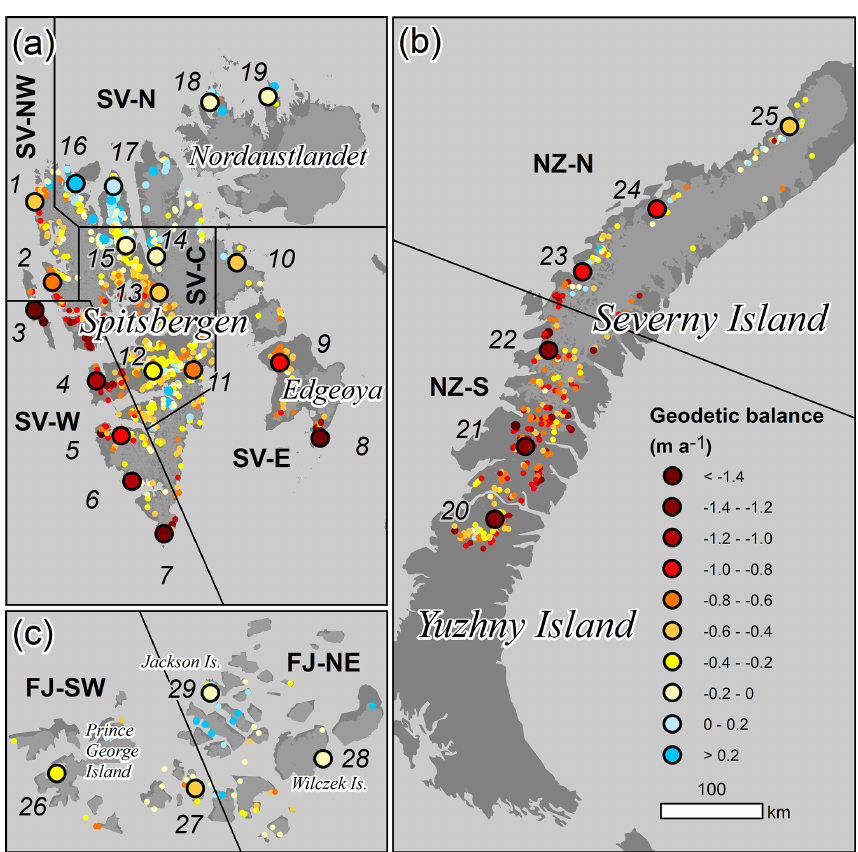
Figure 4. Geodetic balance of mountain glaciers for the study sites (large circles and numbers) on (a) Svalbard, (b) Novaya Zemlya, and (c) Franz Josef Land. Dots indicate individual mountain glaciers with colours corresponding to their geodetic balance, based on the Randolph Glacier Inventory (Pfeffer et al., 2014) and the global glacier elevation change study by Hugonnet et al. (2021), to provide background information. For site-specific details and maps see Table 1 and the